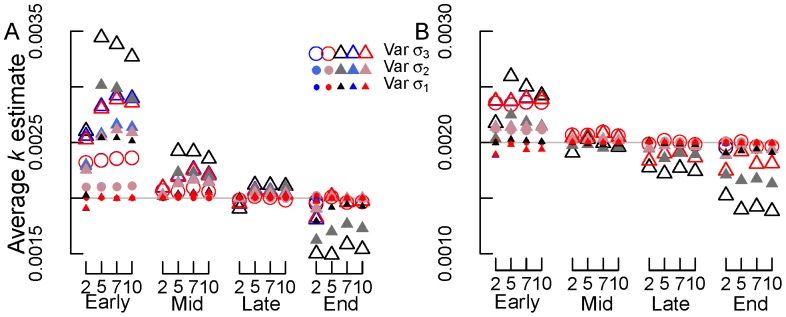
Average k estimates for simulations with variable normal errors (option 1).(A) SV and (B) REP transformations. Early, mid, late and end are early, mid, late and end stage decomposition simulations. The numbers 2, 5, 7 and 10 are the numbers of measurements used in each simulation. Blue circles = NLS, Red circles = Normal ML, gray/black circles = Beta ML. In most cases, nls = Normal ML so that the red circles cover the blue circles. Gray lines in panels (A) and (B) show the true k value of 0.002 d−1.